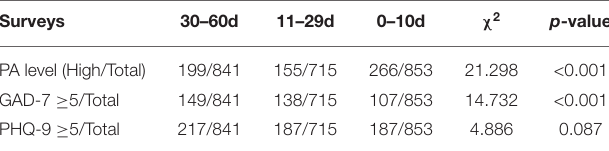
TABLE 3 | Comparison on the positive rates of IPAQ-SF, PHQ-9, and GAD-7 among different working-day groups during the outbreak. Surveys